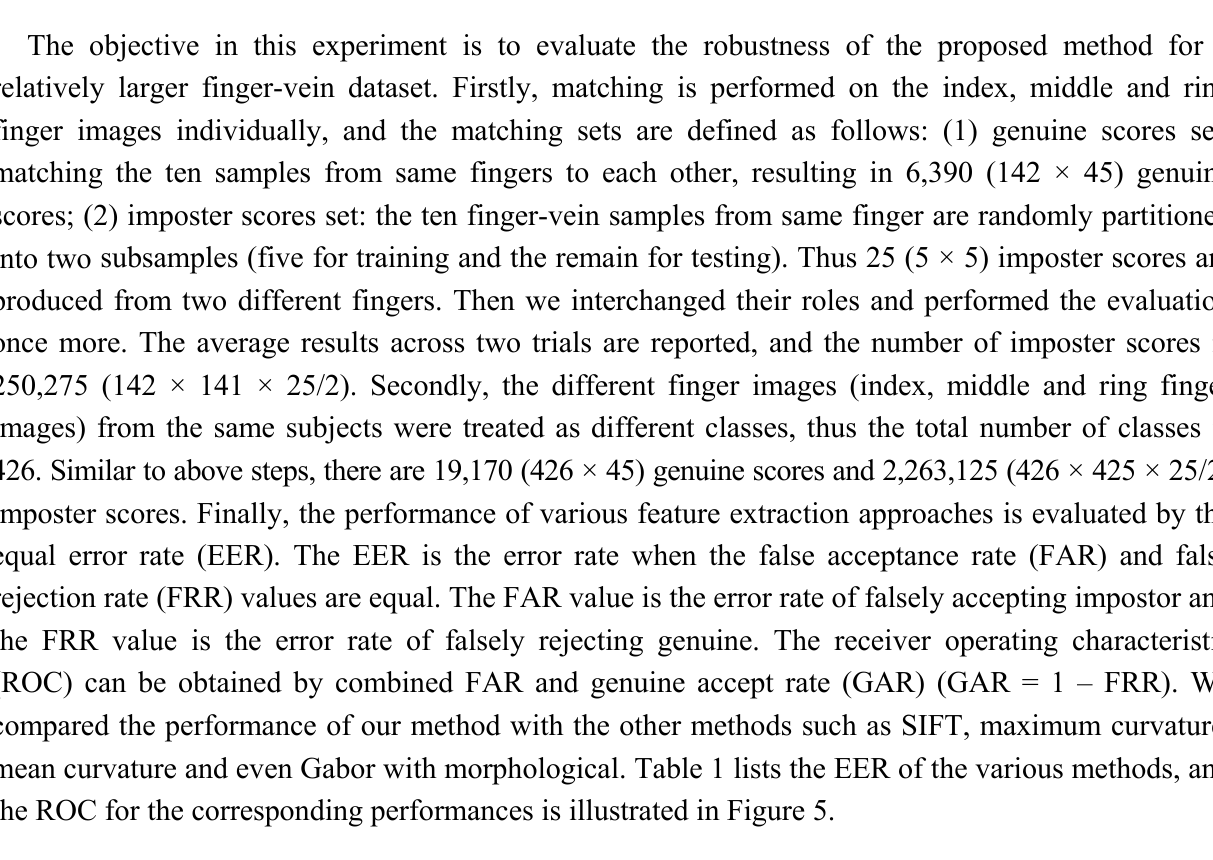
Table 1. Performance from finger-vein matching with various approaches (Database